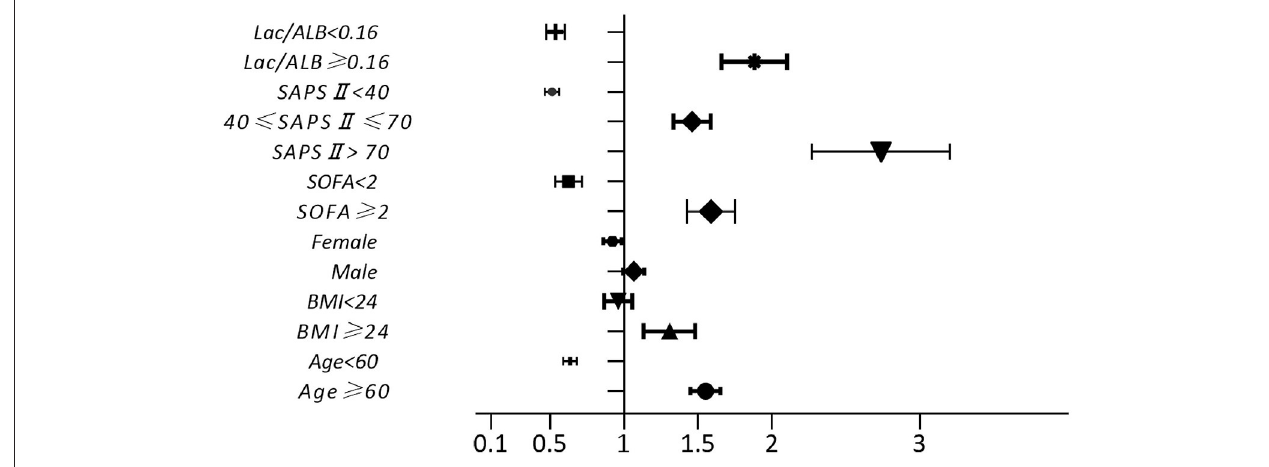
FIGURE 4 | Mortality risk factors of patients with severe sepsis.